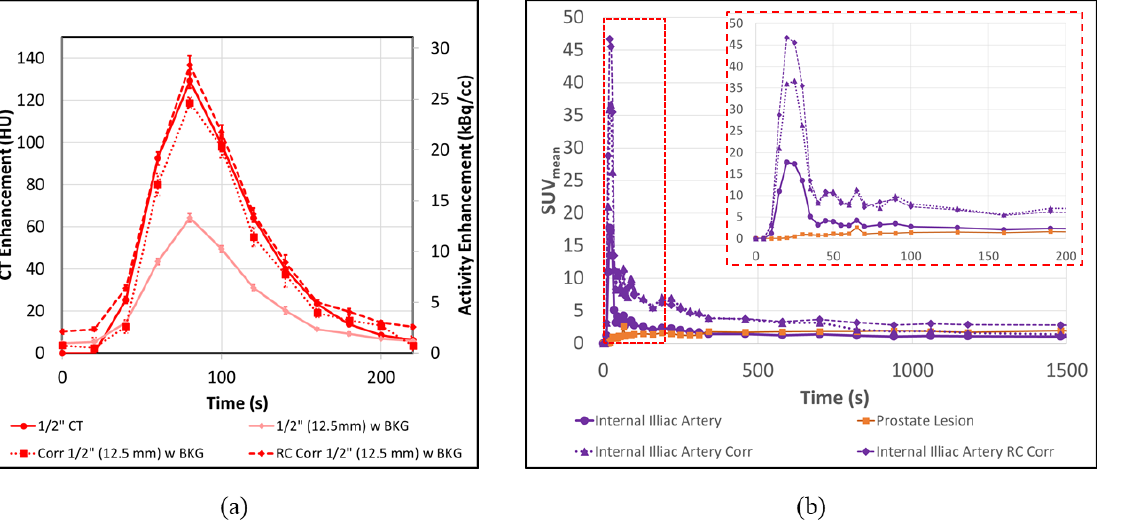
Figure 11. Correction of the AIF can be performed more accurately with the CoA based approach than with traditional recovery coefficient-based methods. ( a ) When applying a recovery coefficient- based correction the peak activity is recovered effectively; however, once the activity in the tubes drops below background levels, the effect of PVE is reversed leading to artificial increased activity levels. ( b ) This artificial increase in the AIF is apparent in patient scans where the RC-corrected AIF remains above tumour levels for the duration of the scan while the CoA method drops back below tumour levels around 800 s.